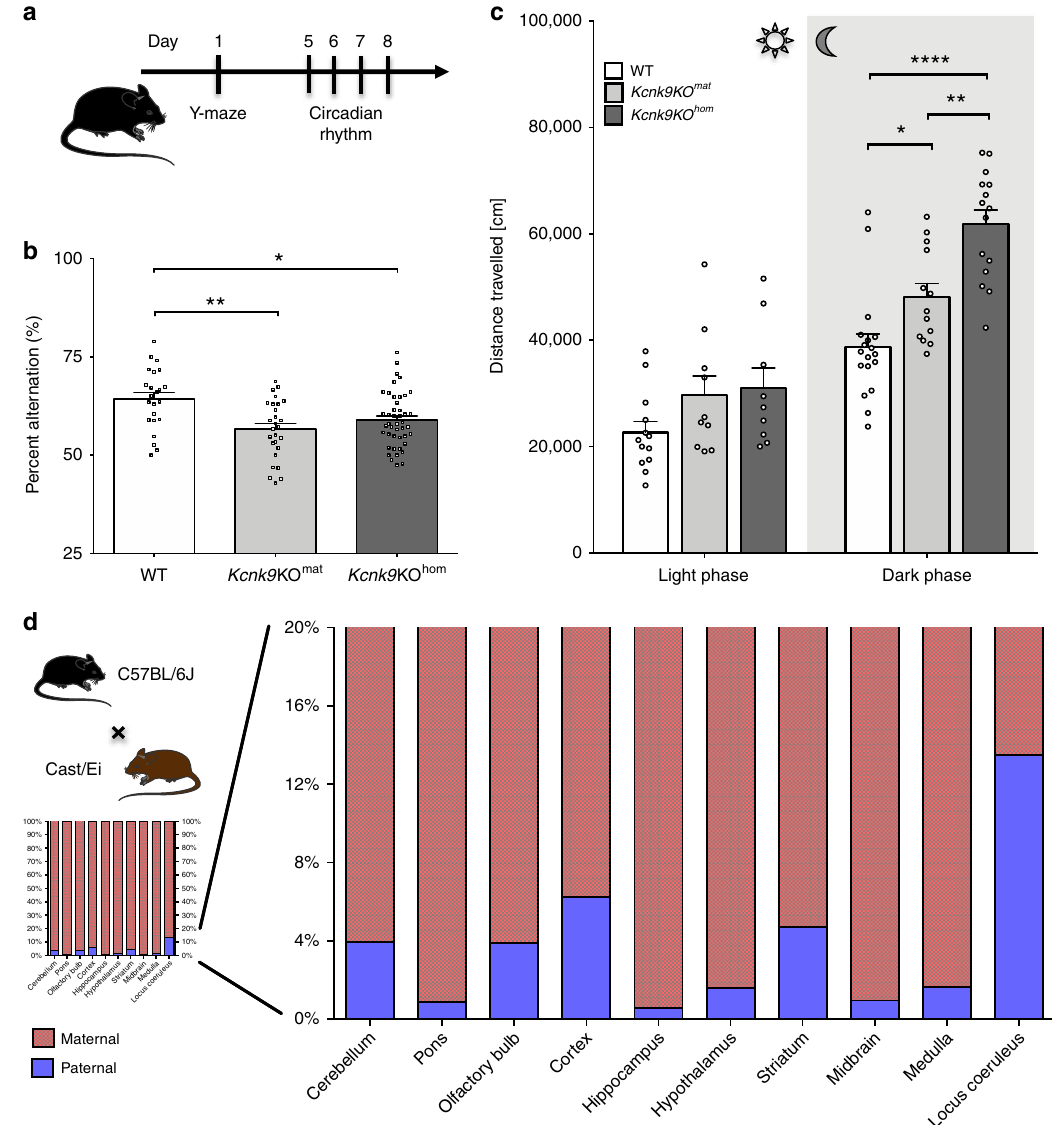
Fig. 1 Deletion of non-canonical imprinted Kcnk9 gene leads to impaired behavior of Kcnk9 KO mice. a Schematic representation of the sequence of mouse behavioral experiments. b Y-maze percentage alternation analysis of WT ( n = 23), Kcnk9 KO mat ( n = 27), and Kcnk9 KO hom ( n = 44) mice. A spontaneous alternation was de fi ned as consecutive entries into all three arms without revisiting an arm. Kcnk9 KO mice display a signi fi cant decrease in percentage alteration compared with WT mice. One-way ANOVA: F (2, 91) = 7.261, P = 0.0012; followed by Bonferroni ’ s multiple comparison post hoc